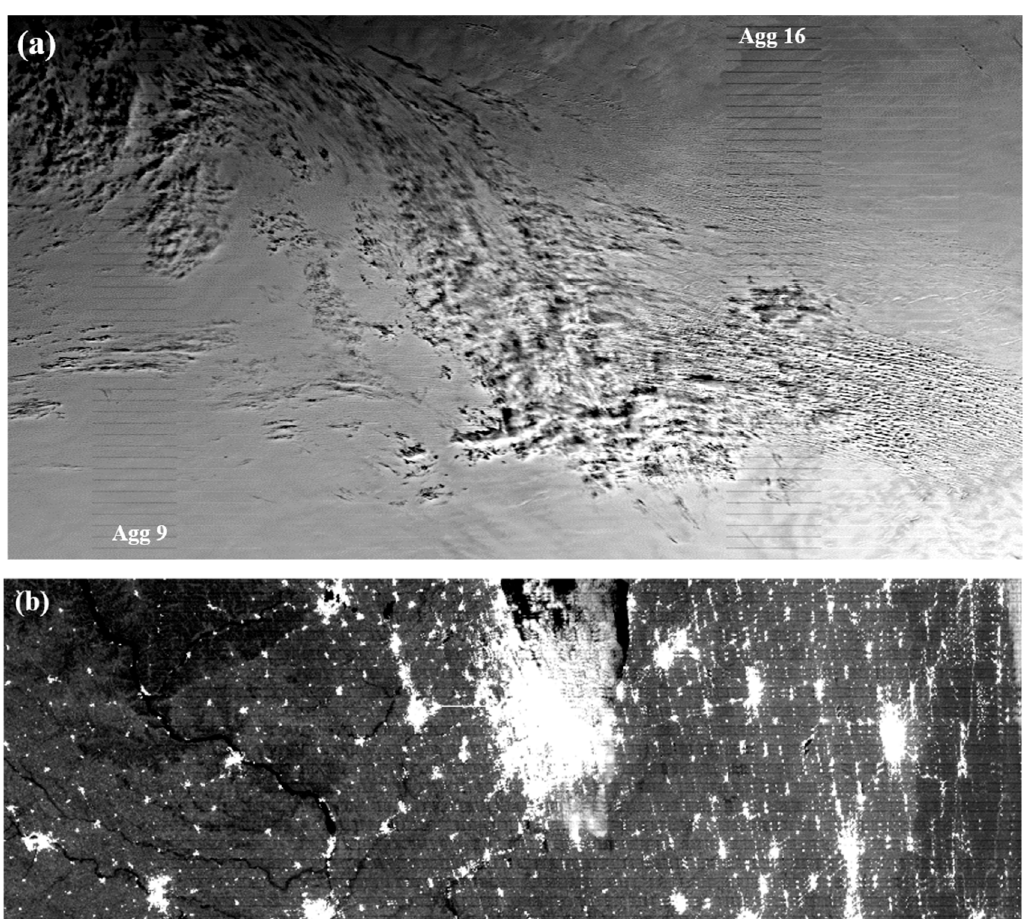
Figure 2. ( a ) NOAA-20 VIIRS DNB daytime radiance image recorded over Antarctica at 8:34 UTC, 14 December 2020, where aggregation zones 9 and 16 are marked. The 768 × 768 (track × scan) pixels are in the right side of the granule (aggregation zones 8–19). The range of radiance is from 4.83 × 10 − 3 W/cm 2 -sr to 1.01 × 10 − 2 W/cm 2 -sr. ( b ) NOAA-20 VIIRS DNB nighttime radiance image recorded over the Midwestern United States at 8:56 UTC, October 24, 2018. The 288 × 864 (track × scan) pixels are in the upper right side of the granule. The range of radiance is from 1.73 × 10 − 9 W/cm 2 -sr to 2.91 × 10 − 6 W/cm 2 -sr.